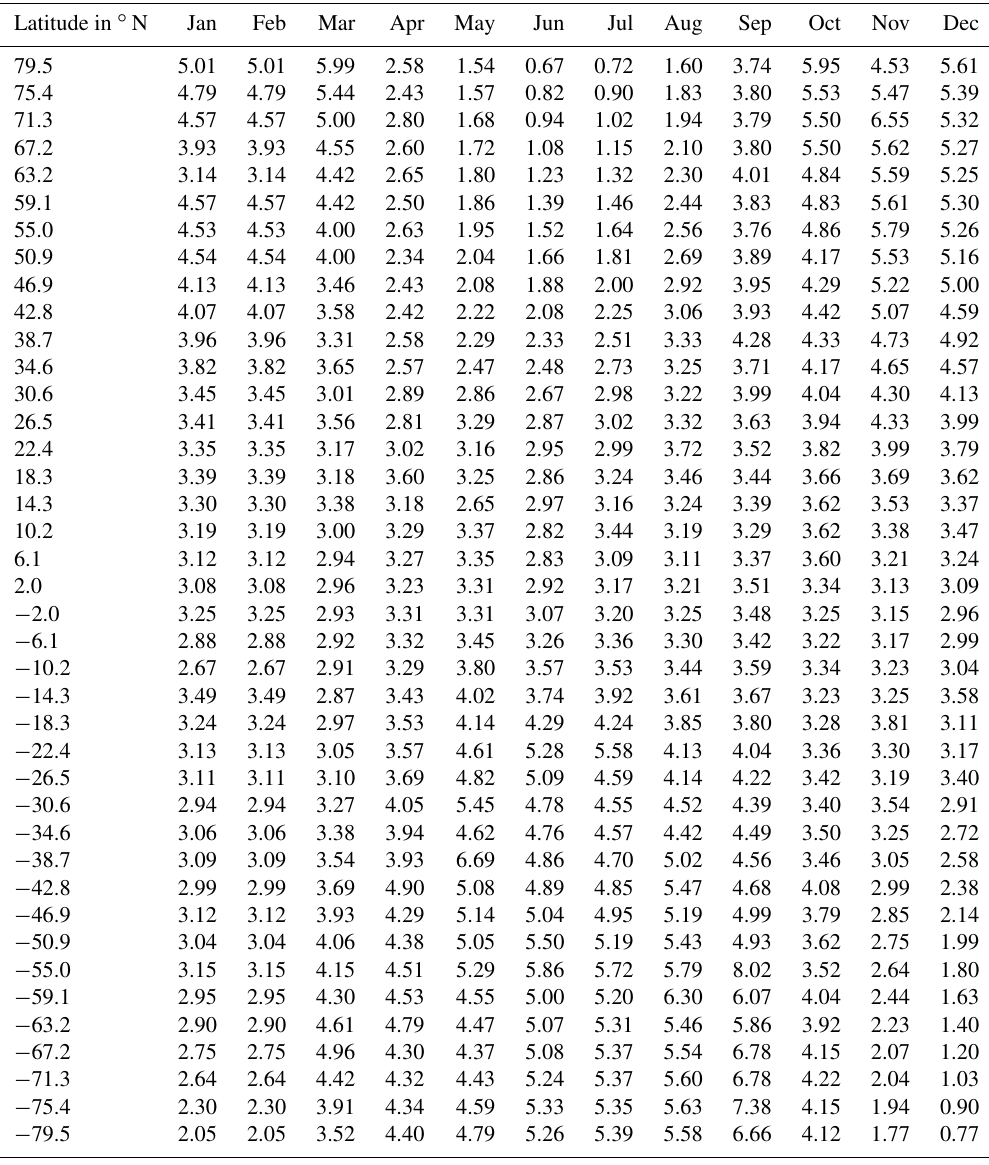
Table 2. Ensemble mean VCD for 40 latitudes within ± 82 ◦ N in 10 9 cm − 2 . Latitude in ◦